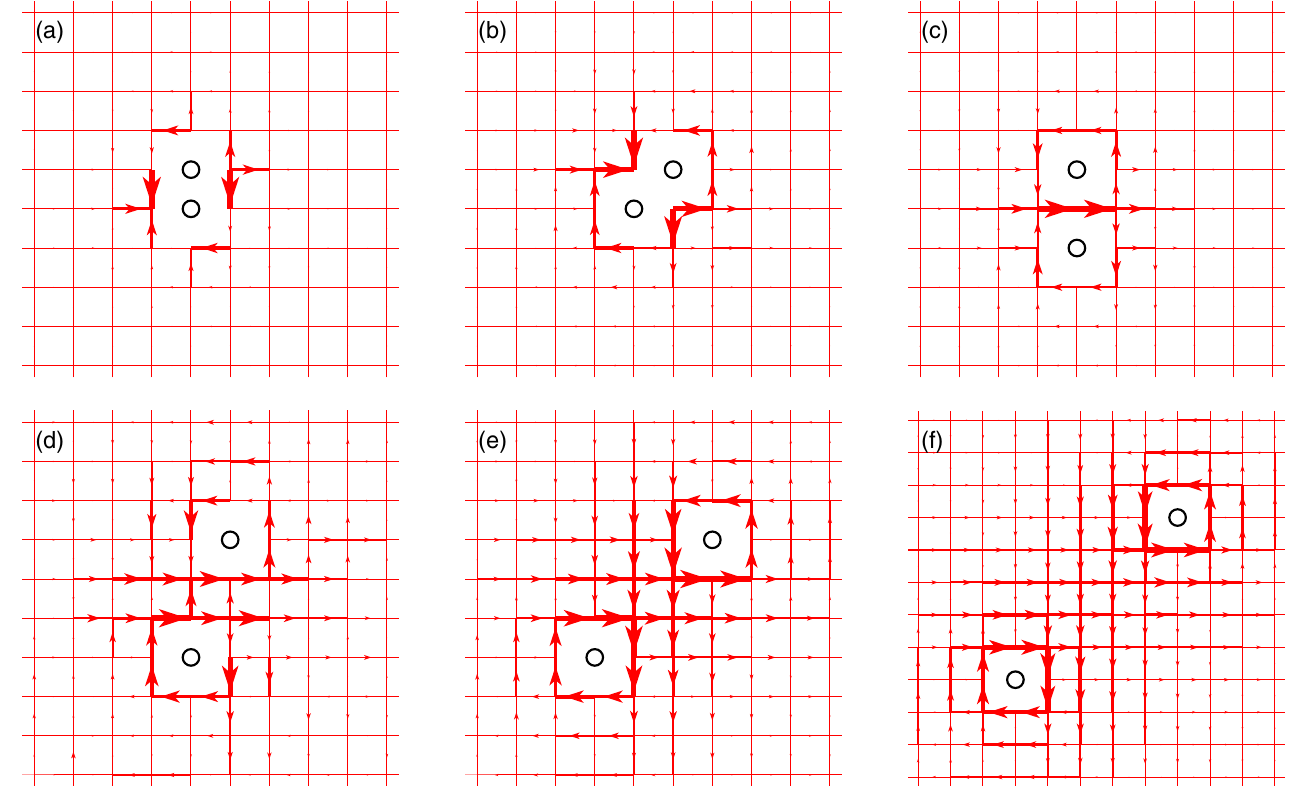
FIG. 9. The spin-current patterns in j Ψ − i 2 with two holes projected to different locations on a 16 × 16 lattice (only the central part is h shown). The dipolar configuration of the spin currents is clearly indicated with the increase of the hole-hole distance from (a) to (f), which illustrates the crucial role of the phase-string effect in the hole pairing as opposed to the absence of both in j Ψ 0 i 2 . Note that an h opposite chirality of the spin-current patterns is also present in j Ψ − i 2 , which is not shown here for h